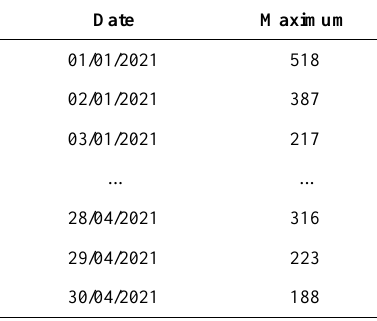
Table 2. Maximum variable value